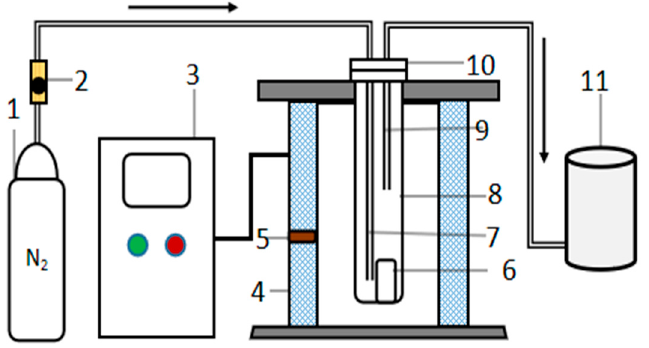
Figure 1. Schematic diagram of the experimental setup. 1: gas cylinder, 2: flowmeter, 3: control cab- inet, 4: furnace body, 5: heating element; 6: crucible; 7: gas inlet, 8: furnace tube, 9: gas outlet, 10: 10: flange, 11: tail gas washing flange, 11: tail gas washing tank.